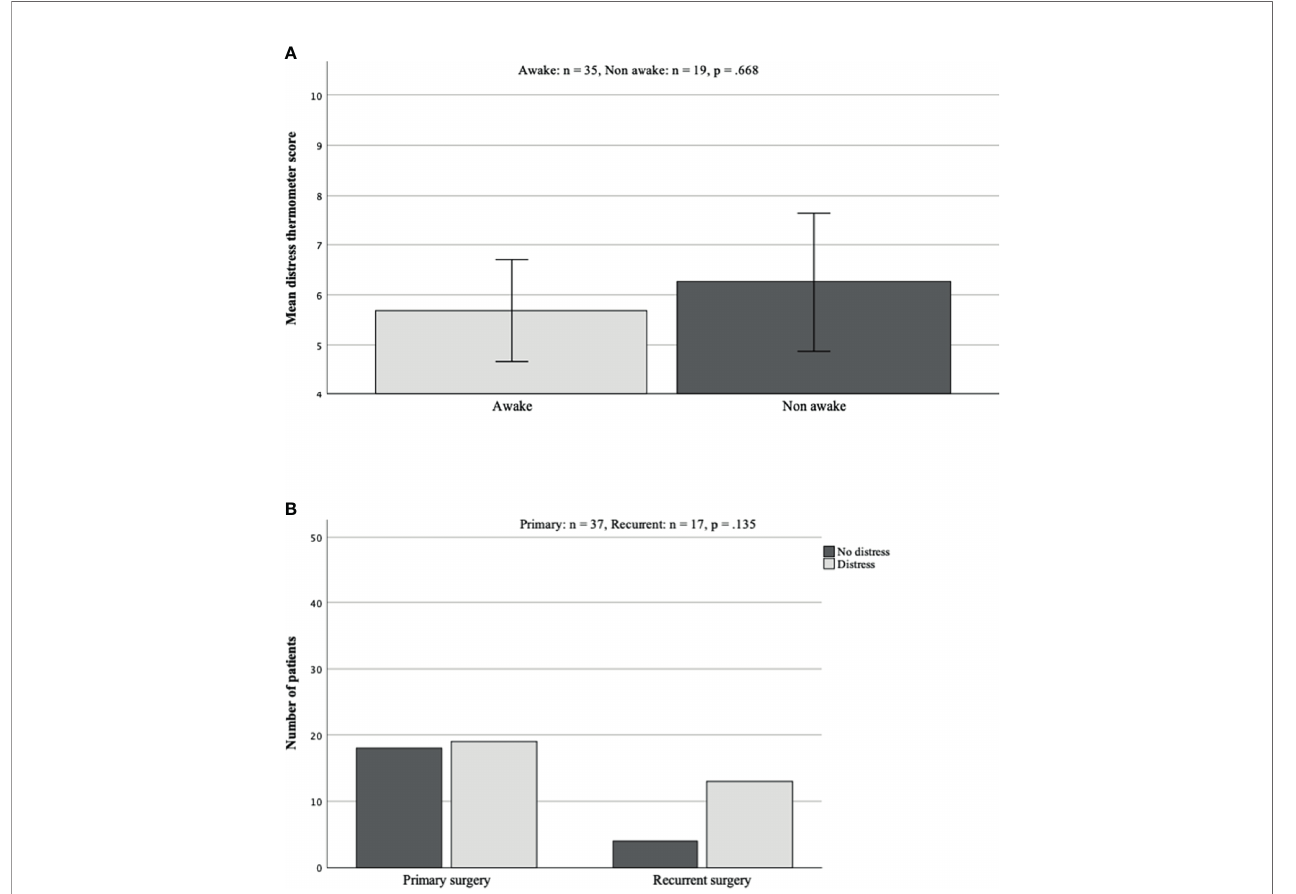
FIGURE 2 | (A, B) Mean scoring in DT in group comparison. There were no signi fi cant differences seen between both patient groups ( A ; p = 0.668). Concerning comparison of reported distress in either primary or recurrent surgery, although not statistically signi fi cant, patients undergoing recurrent surgery reported distress more often (B) . DT, distress